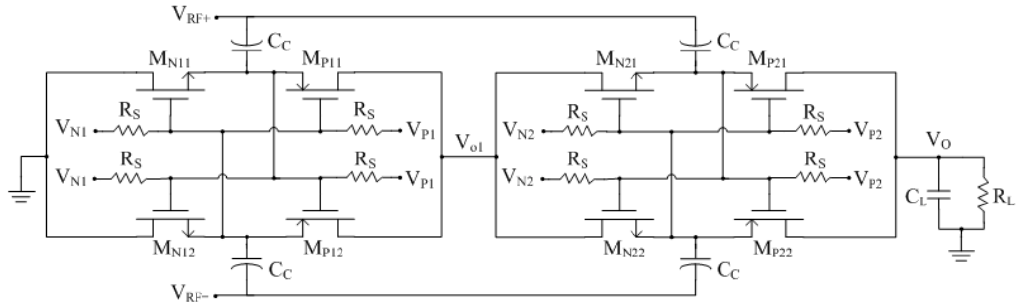
Figure 6. Schematic of the proposed two-stage rectifier.